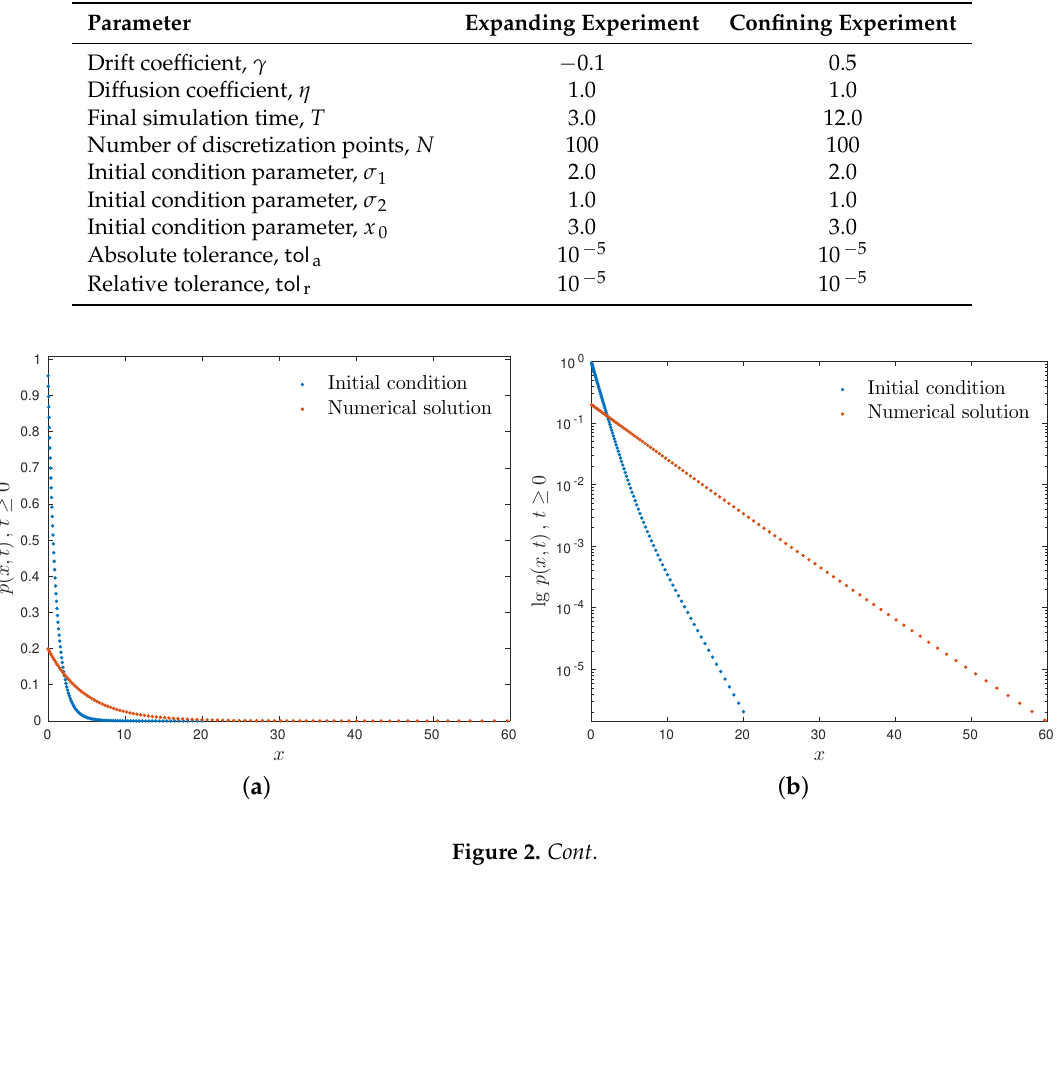
Table 2. Numerical parameters used in unsteady computations.